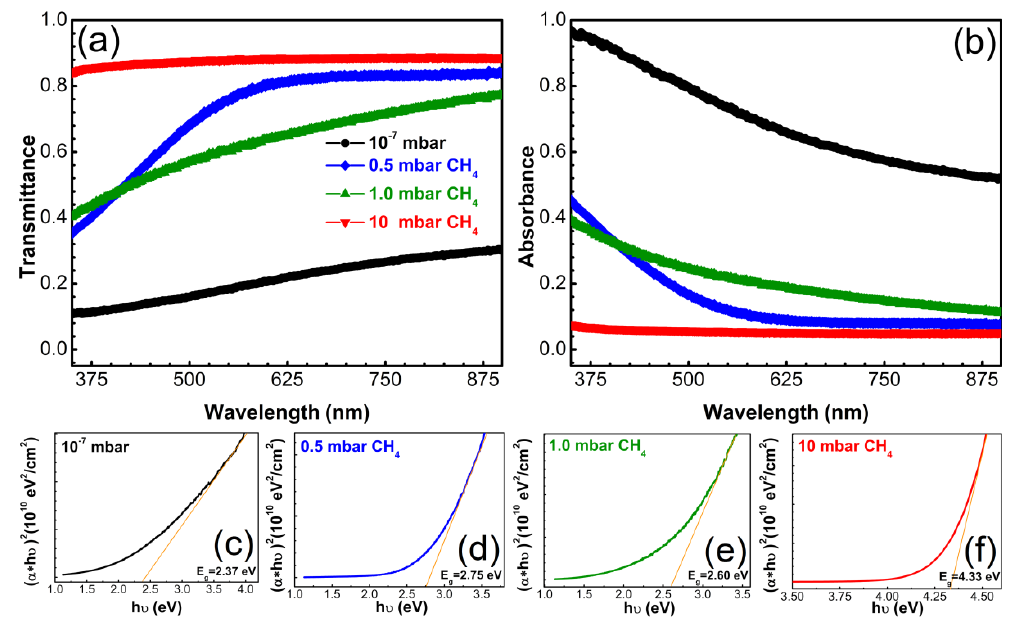
Figure 7. ( a ) Transmittance and ( b ) absorbance spectra of carbon films synthesized by PLD in different deposition ambients on bare quartz substrates; ( c – f ) Tauc plots for assessment of the optical band gap.